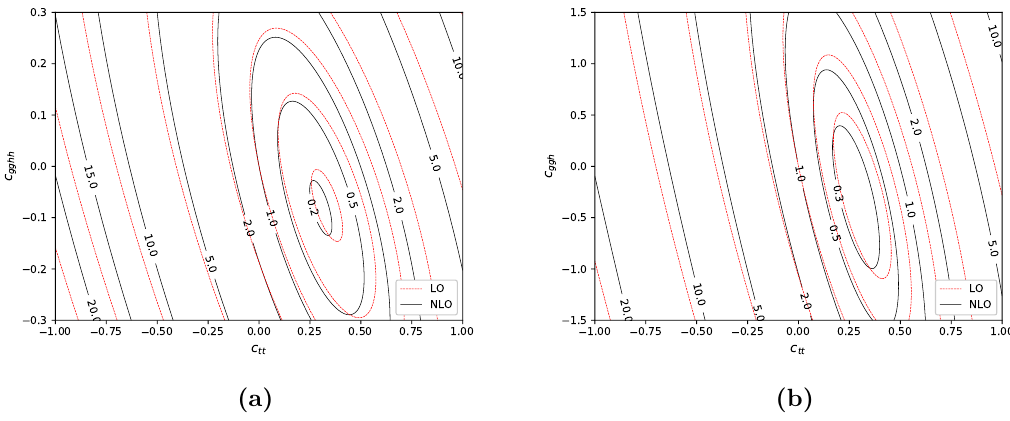
Figure 7. Iso-contours of (cid:27)=(cid:27) SM : (a) c gghh and (b) c ggh versus c tt